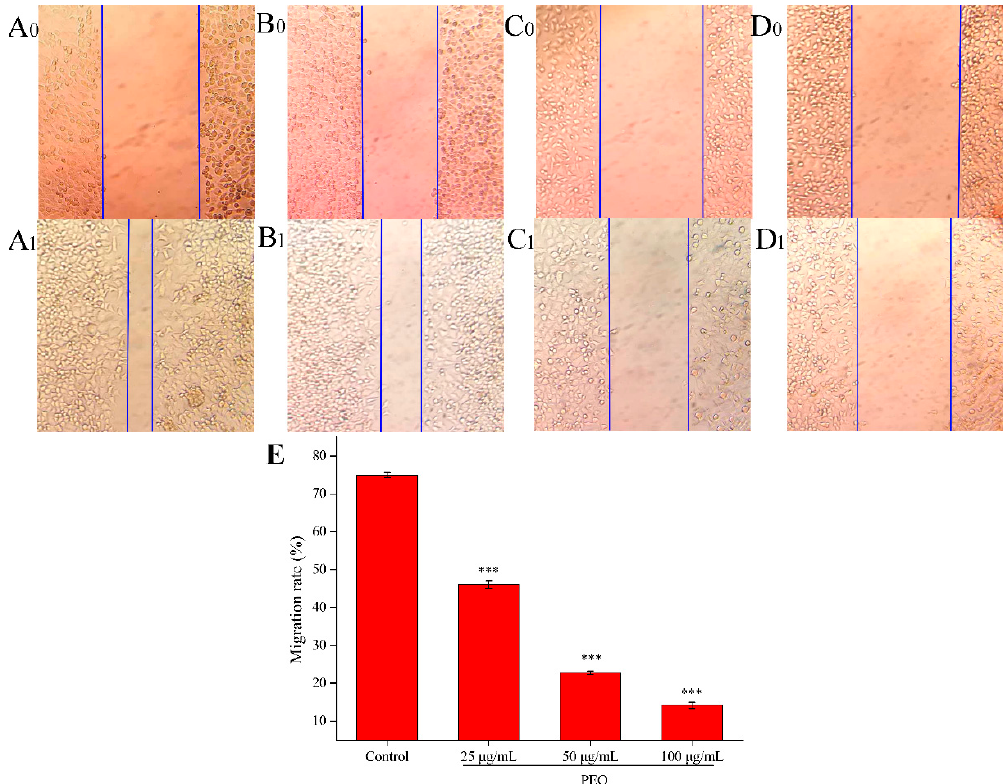
Figure 3. Effects on MGC-803 cell migration capacity. The A–D represented PEO concentrations were 0, 25, 50, and 100 µg/mL, the subscript 0 and 1 that represented the photos (100 ×) were taken after MGC 803 cells exposing to the PEO 0 and 24 h, respectively; E was the migration rates of experimental groups that treated 24 h with PEO compared with 0 h (*** p <